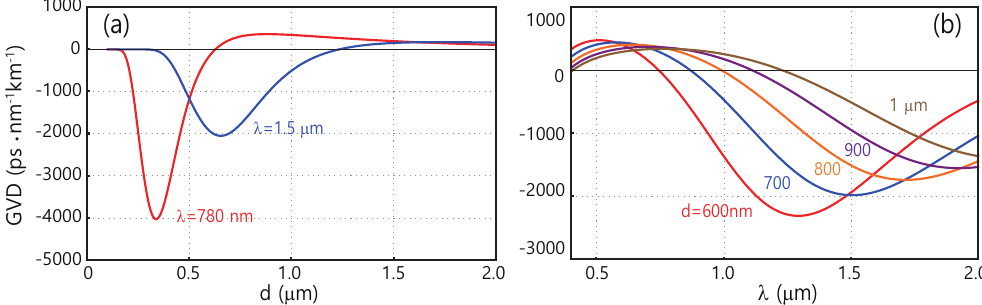
Figure 13. Group velocity dispersion of the fundamental modes ( a ) as a function of diameter at λ = 780 nm and λ = 1.5 µ m, ( b ) as a function of wavelength at different